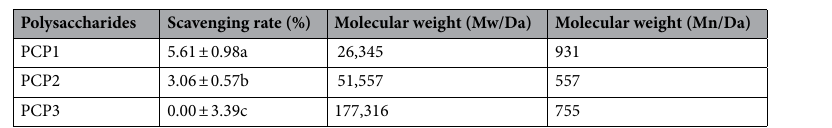
Table 2. The clearance rate of ·O 2 - and molecular weight of polysaccharides in Polygonatum sibiricum.